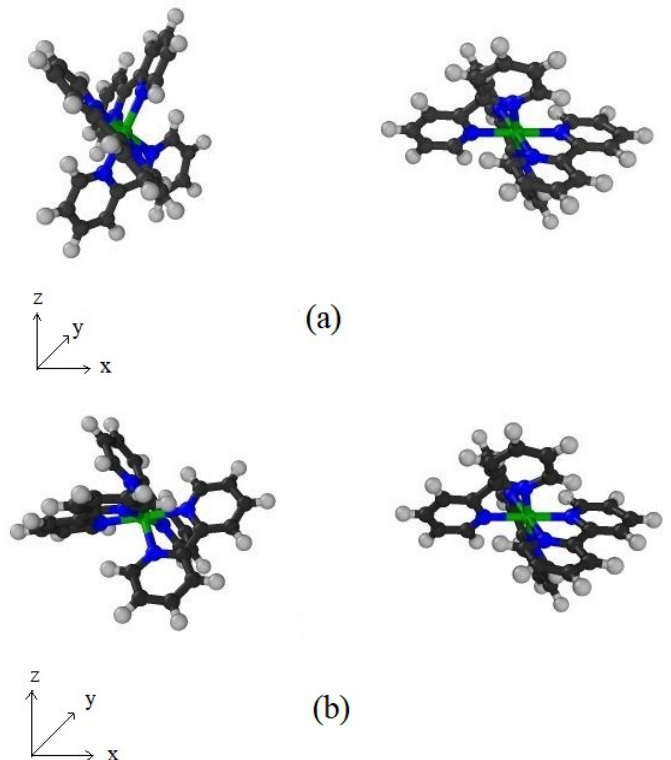
Figure A1. Configuration of first dye molecule located on left hand side: ( a ) gives high energy and ( b ) gives low energy where second dye molecule is fixed on right hand